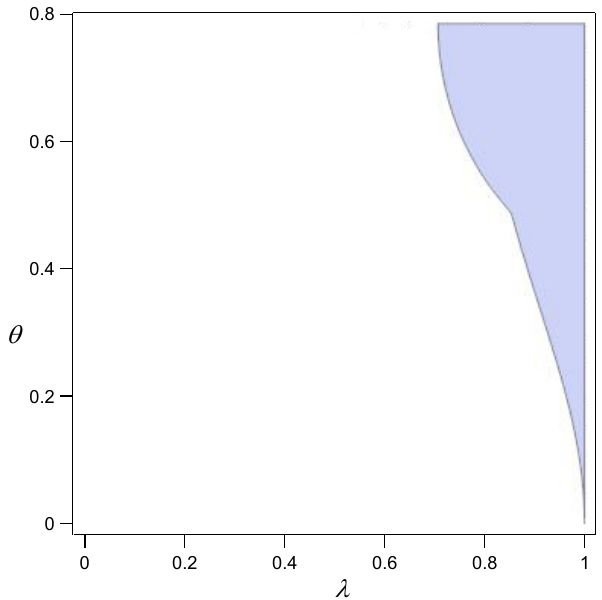
Figure 3: The horizontal axis represents λ and the vertical axis represents θ . The shaded region depicts the nonlocal region of the state